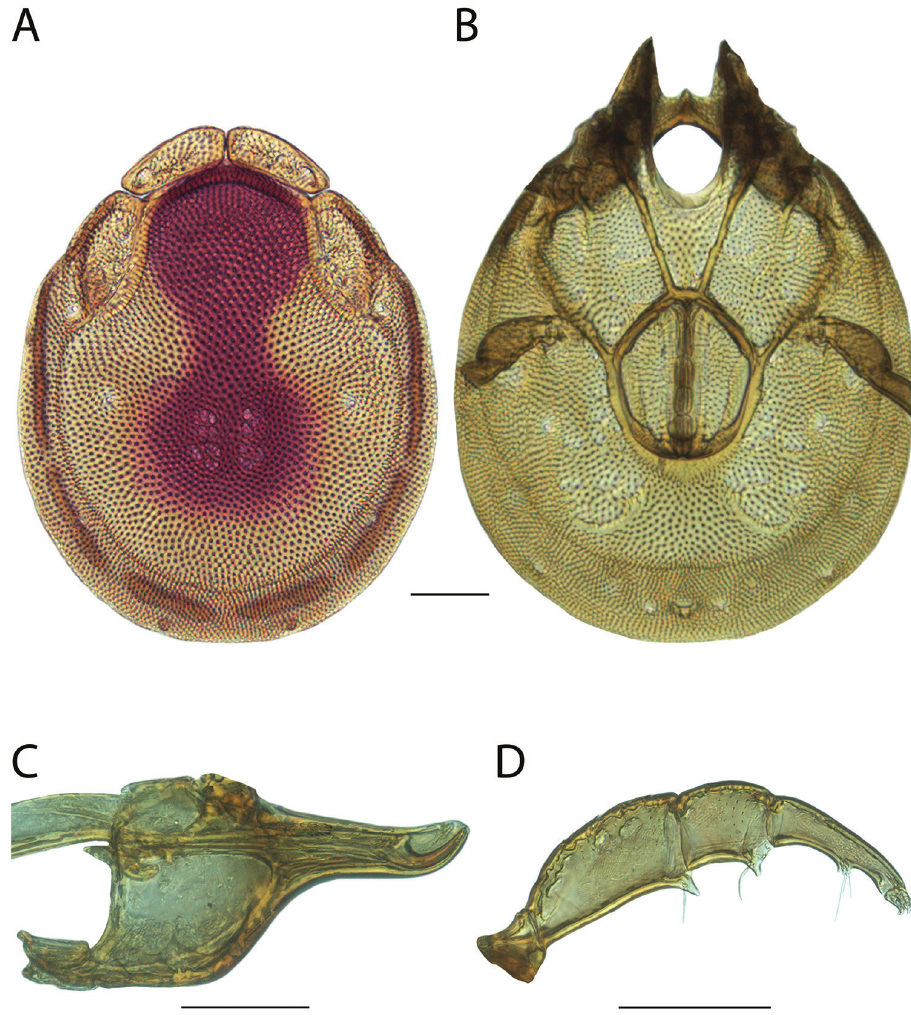
Figure 76. Torrenticola feminellai sp. n. female: A dorsal plates B venter (legs removed) C subcapitulum D pedipalp (setae not accurately depicted). Scale = 100